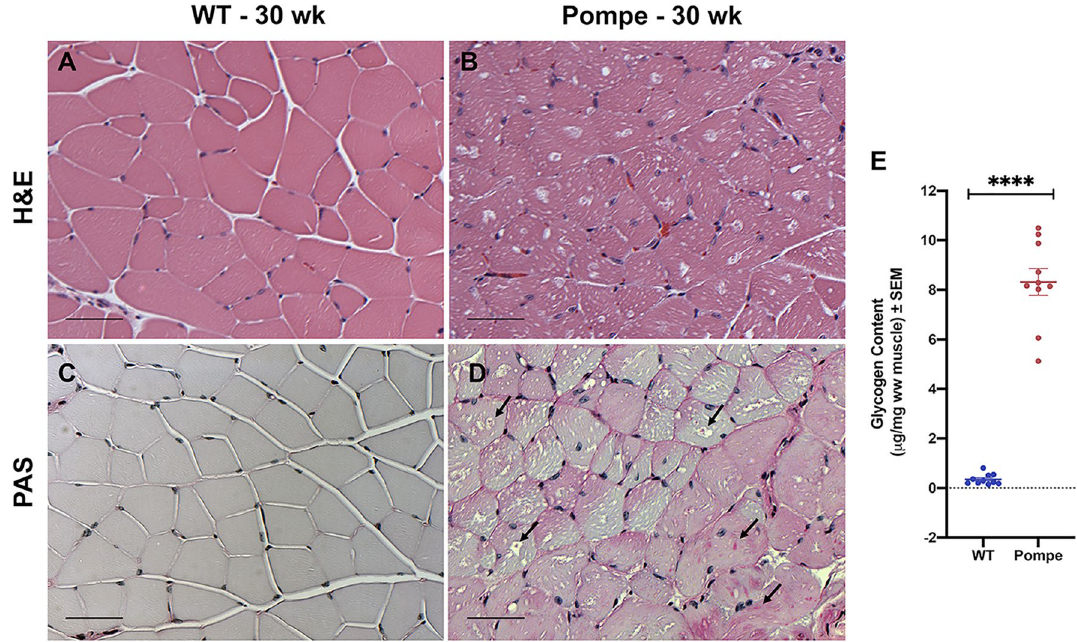
Figure 3. Histological analysis and biochemical determination of gastrocnemius muscle glycogen content in WT and Pompe mice. Representative examples of gastrocnemius (GA) muscle histology including standard H&E staining ( A , B ) as well as Periodic Acid Schiff (PAS) staining for glycogen for WT ( C ) and Pompe ( D ) mice at 30 weeks. ( E ) Glycogen Content in GA muscle from WT and Pompe mice as determined biochemically, reported as mean ± SEM with units µg glycogen/mg wet weight (ww) muscle. (Unpaired t-test). * p < 0.05; ** p < 0.01; *** p < 0.001; **** p < 0.0001; ns not significant. Bar = 50